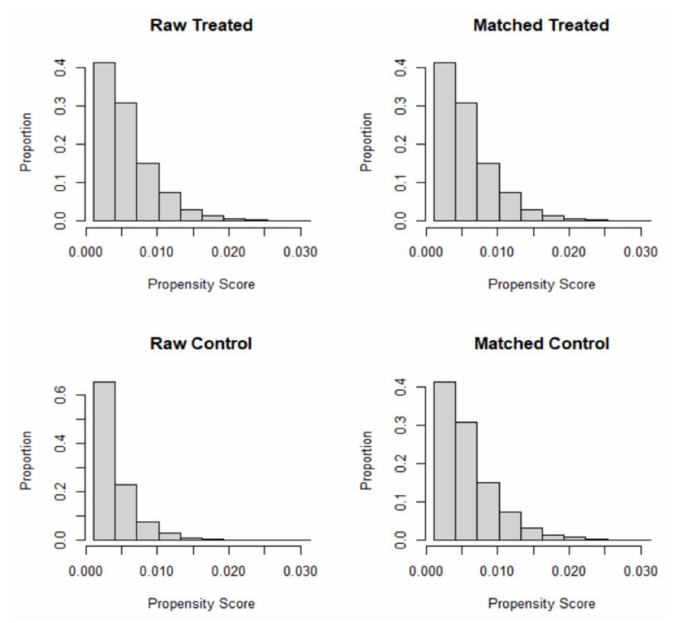
Figure 2. Histograms displaying propensity scores before and after matching. Table 3. Prevalence of risk factors in matched